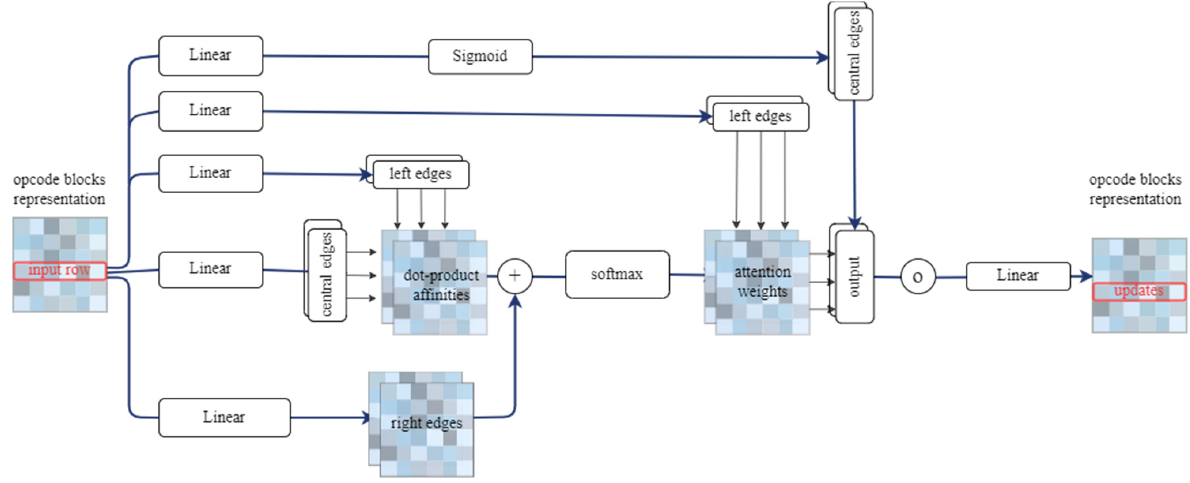
Figure 3. Triangular self ‐ attention around starting opcode.